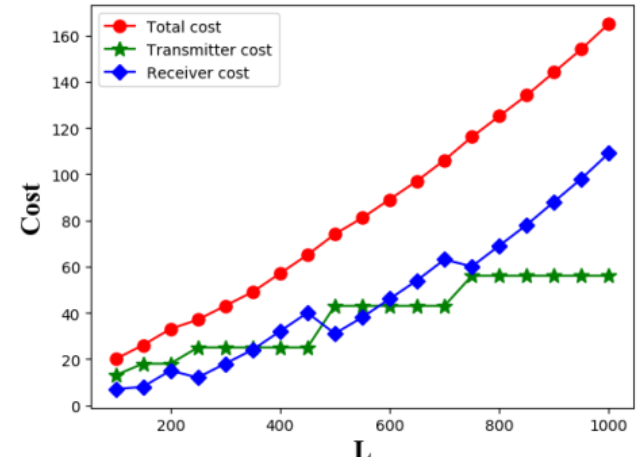
Figure 24. The relationship between line barrier length L and coverage cost.